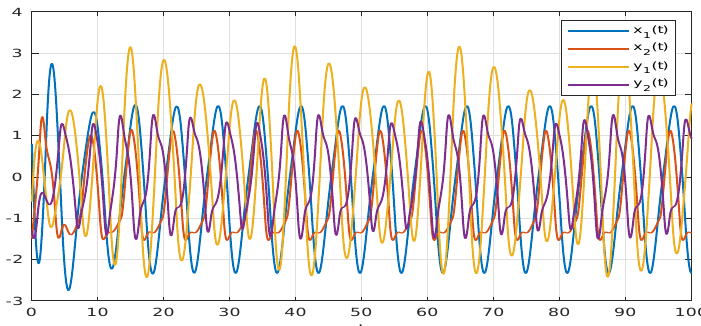
Figure 5. The drive-response MINNs without the